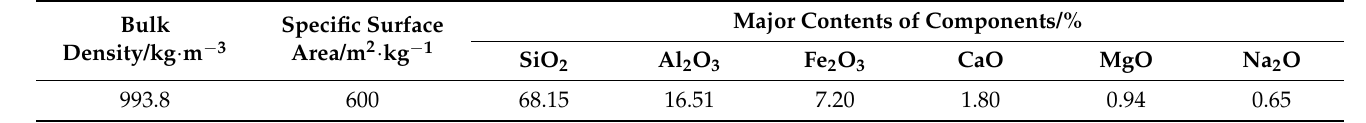
Table 2. The main material property indicators and components of recycled brick powder.